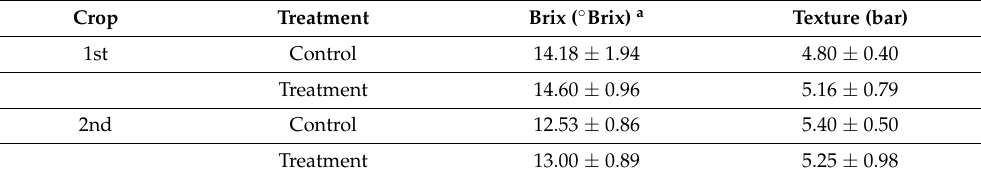
Table 3. Effect of Trichoderma asperelloides PSU-P1 on postharvest quality of muskmelon. Crop